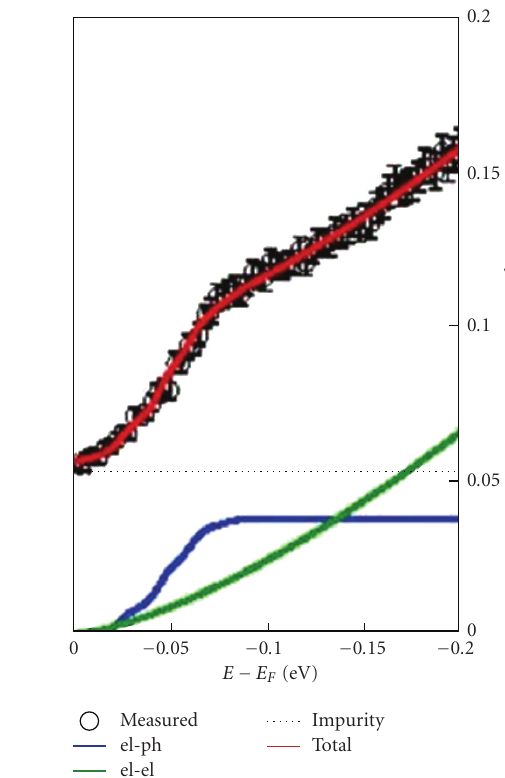
( ω ) F ( ω ) is in the inset. (b) Top: e ff